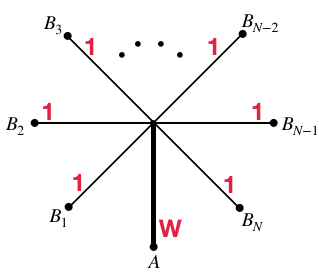
Figure 1 . The graph model of extreme rays of the holographic entropy cone, whose symmetrized entropies S p are extreme in the holographic cone of average entropies (HCAE). For N odd (as is assumed in this paper), the parameter w takes odd values between 1 and N . The graph was drawn following